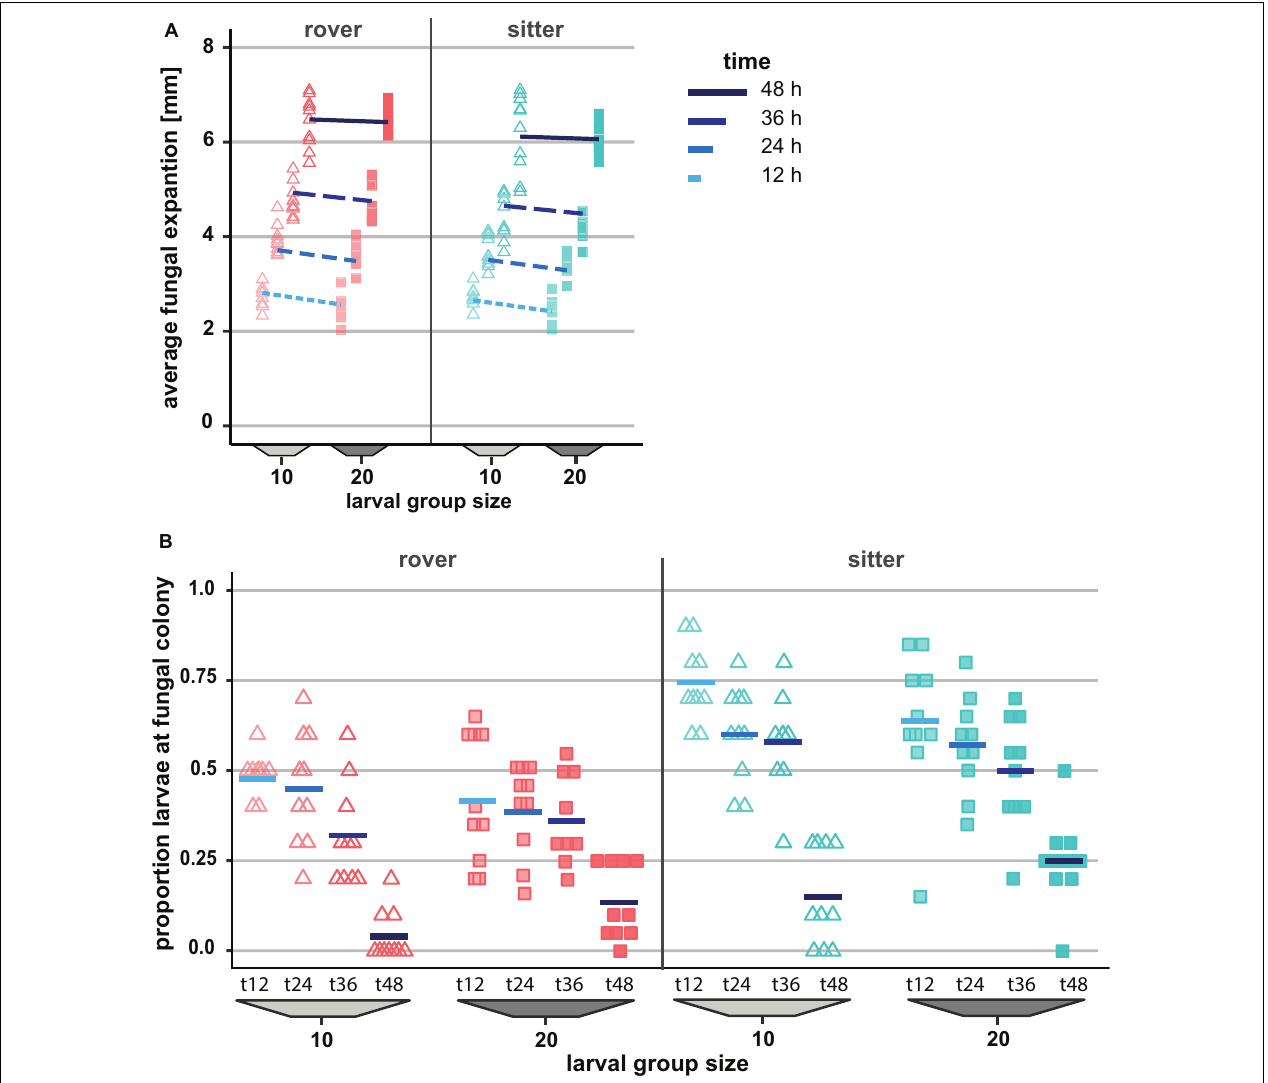
FIGURE 5 | Effect of genetically determined variation in the locomotion behavior of Drosophila melanogaster larvae on the spread of the insecticidal filamentous fungus Aspergillus nidulans . (A) Inhibition of the fungal expansion by rover and sitter Drosophila larvae in different group sizes (constant density = 0.4 larvae/mm). Fungal growth was determined for four time points after larval transfer as the average expansion of the fungus into the substrate surface per millimeter of growth front. Lines represent the fitted model estimates for the four time points (GEE; Table 4 ). (B) Proportion of larvae in direct contact with the fungal colonies at four different time points after larval transfer ( Table 4